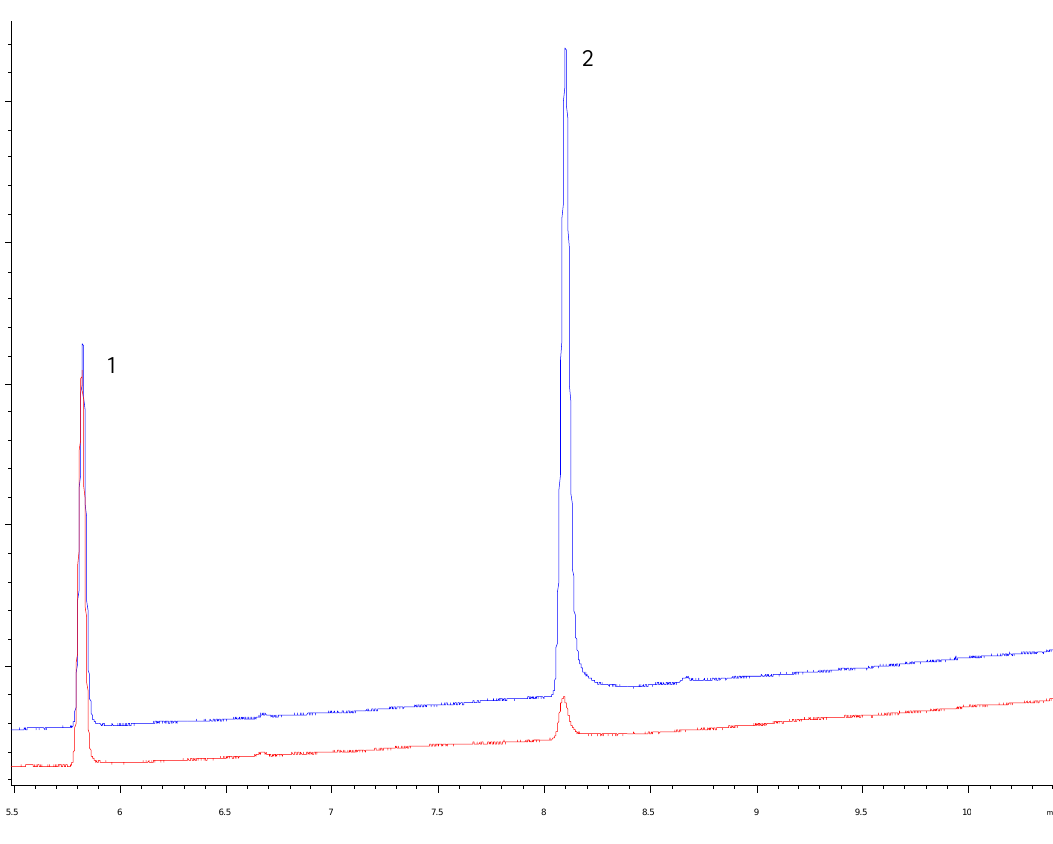
- 97.6 ± 4.56 - Remain β -CD (%) - 0.31 ± 0.13 - CC, control cheese without β -CD in milk; EC, experimental cheese with 1% β -CD in milk; SN, soluble nitrogen (% as protein); NNP, non-protein nitrogen (% as protein); REE (%), relative experimental error; Mean standard